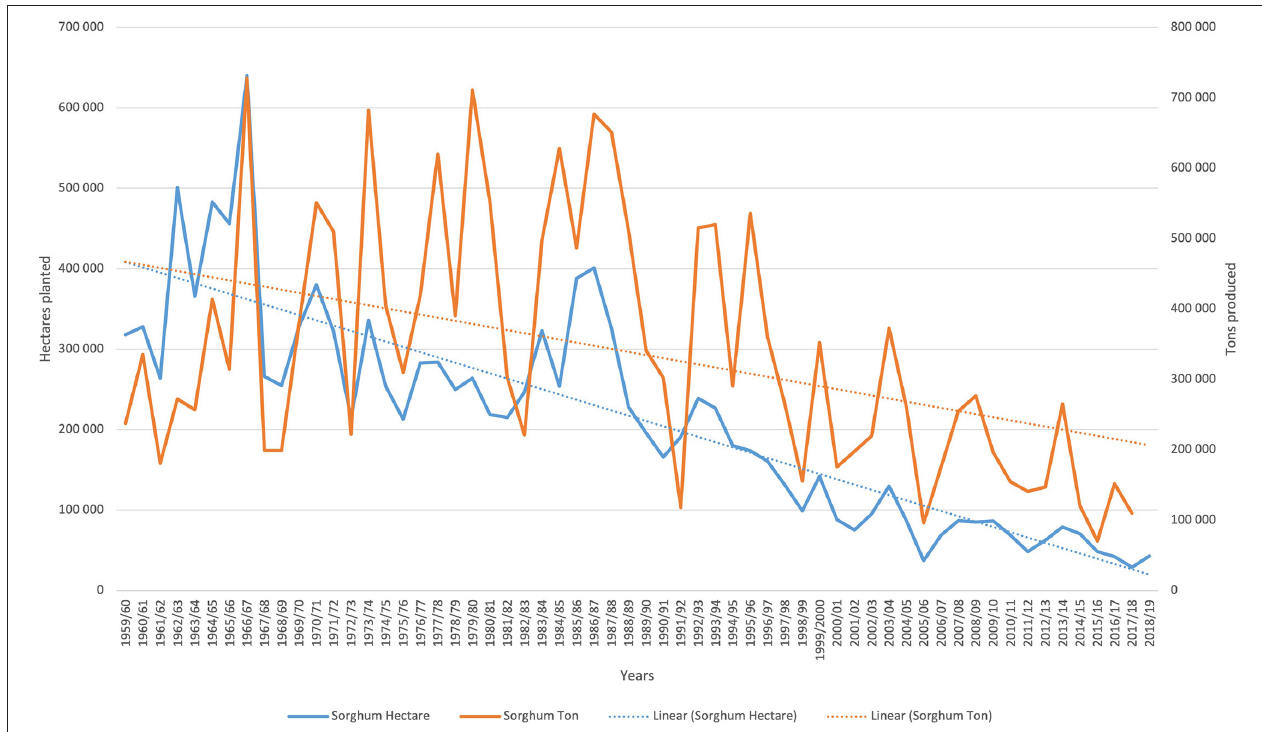
FIGURE 1 | Area of sorghum planted (Ha) and amount produced (tons) in South African from 1959/60 to 2018. (Source data: GRAIN